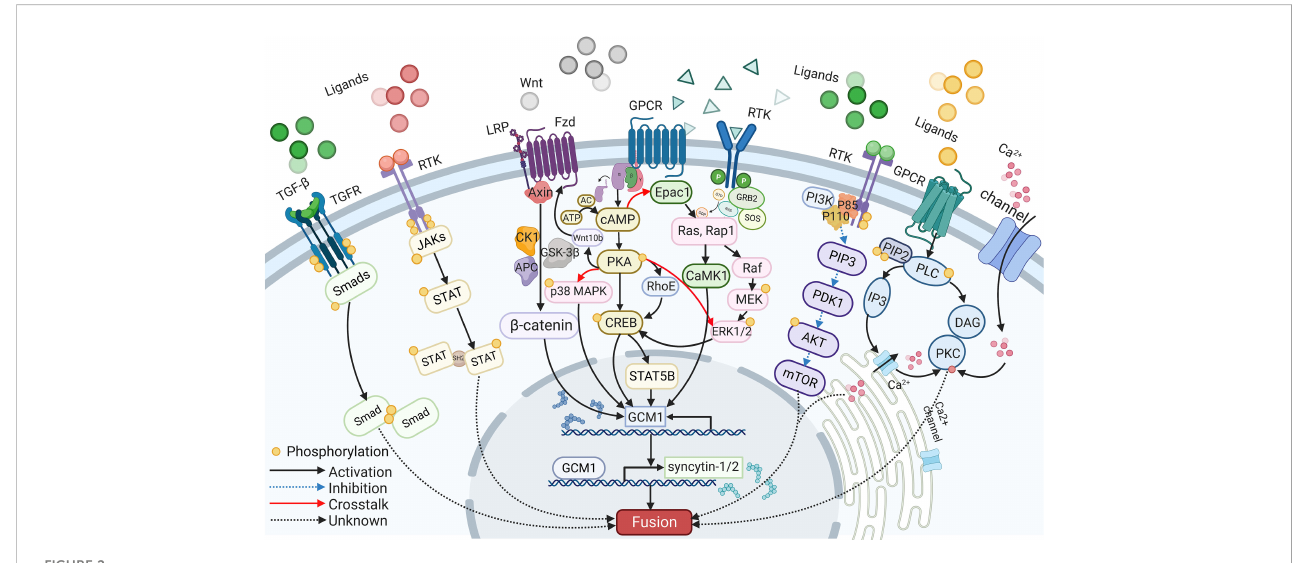
FIGURE 2 The signaling pathways participate in